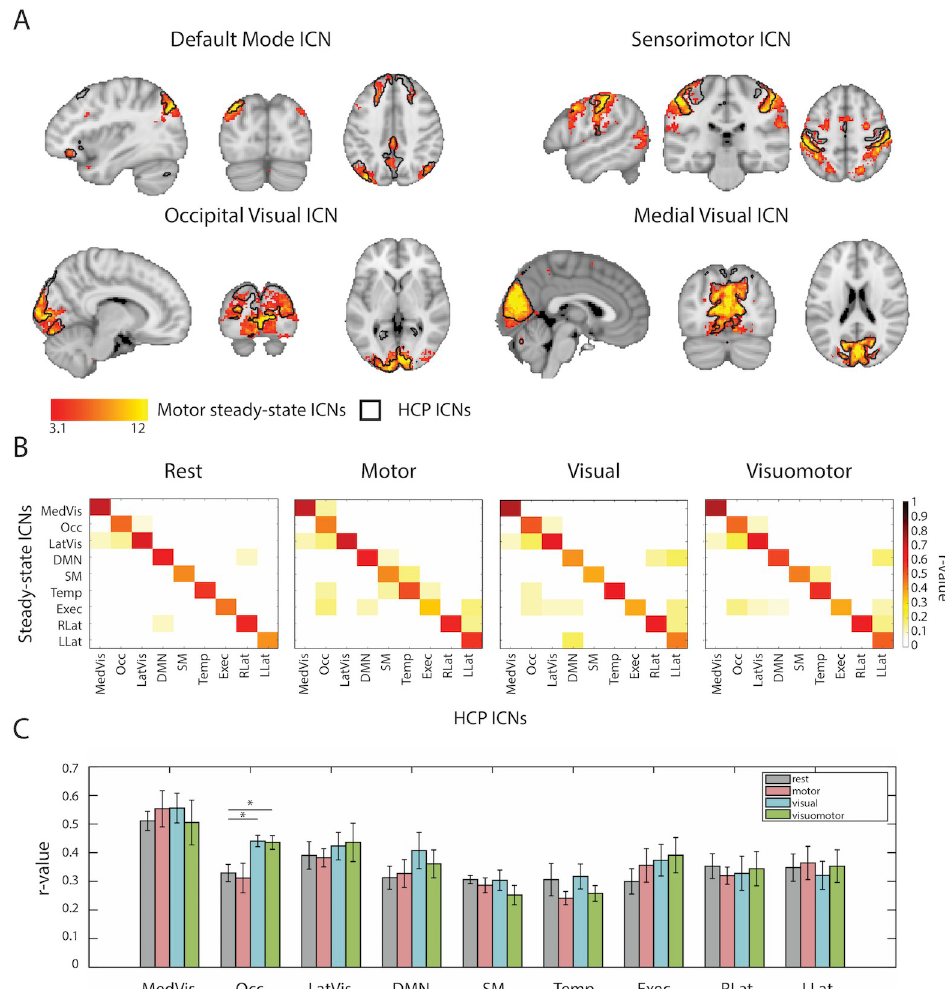
Fig 4. Spatial variability of ICNs between different steady-states. (A) Spatial maps of four task-related ICNs extracted from the motor condition (depicted in red-yellow scale) overlaid on the same ICNs extracted from the HCP data (depicted as black contours). (B) Whole brain correlation matrices of 9 major ICNs from the HCP data and their counterparts found in the steady-states data. Each ICN is correlated with all other ICNs. (C) Bar graph depicting mean spatial correlation coefficients (calculated from 100 bootstrapped ICA decomposition) of 9 major ICNs extracted from each of the steady-states conditions to their HCP counterparts. Note that only the Occipital Visual ICN (Occ) shows significant differences in its spatial correspondence to the HCP’s Occipital Network. Asterisks denote significance as determined using bootstrap percentile confidence intervals (see Methods). MedVis stands for Medial Visual